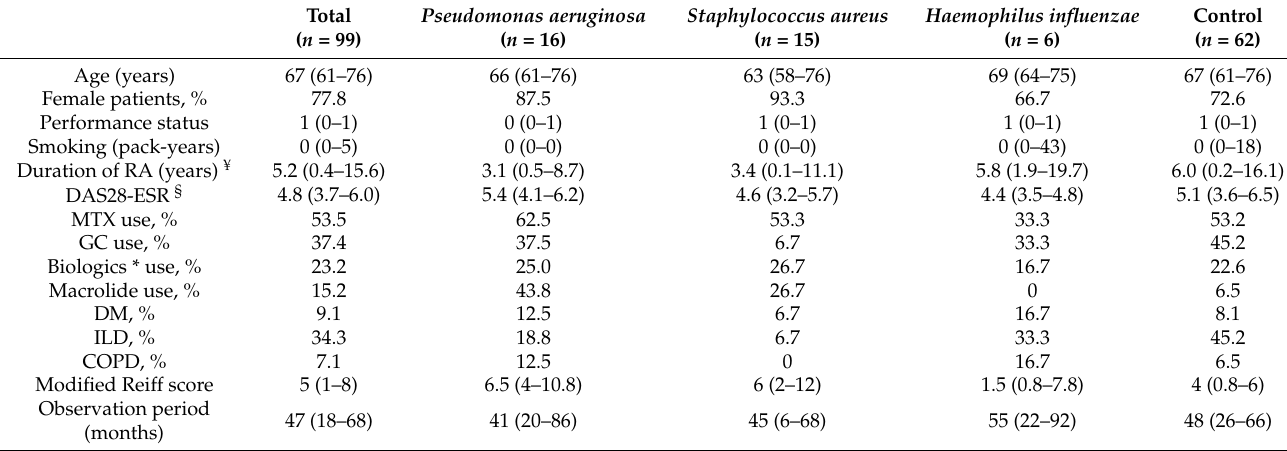
Table 1. Characteristics of patients with rheumatoid arthritis for each microorganism in the lower respiratory